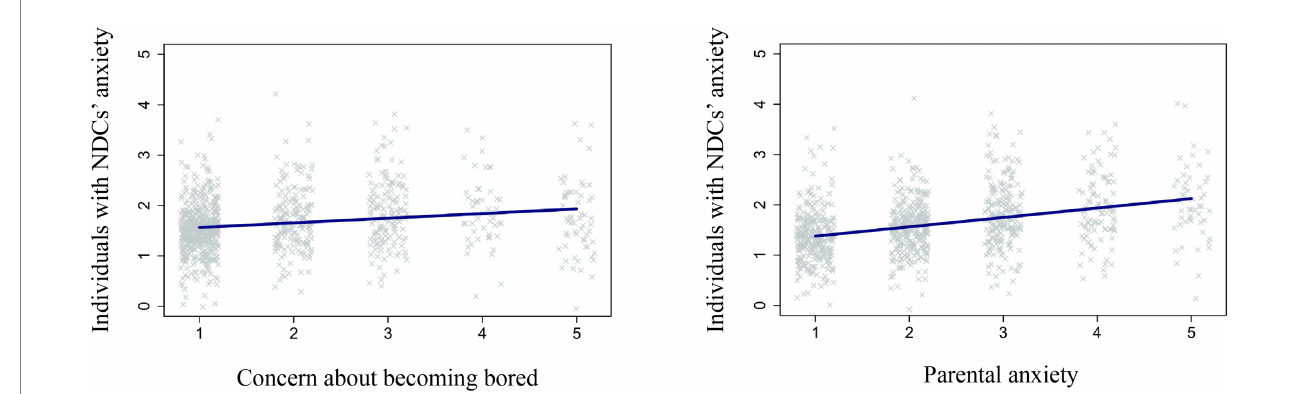
FIGURE 4 Continuous main positive effects of concern about becoming bored and parental anxiety on individuals with NDCs’ anxiety. Anxiety and concerns are measured with a 5-point Likert scale from 1 (not anxious/not concerned at all) to 5 (very anxious/extremely concerned). The level of anxiety and concern of individuals with NDCs was reported by their parents or caregivers. NDCs = neurodevelopmental